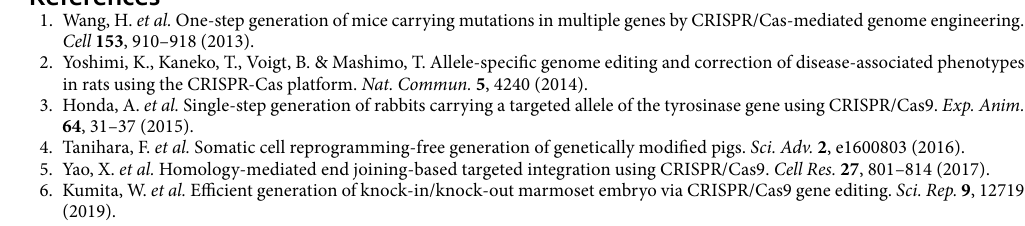
Supplementary Table 2. For genotyping of mouse Rosa26 and rat Thy1 loci, nested PCR was performed using the external primers as follows: 5 ′ -GCT CTC GGG GCC CAG AAA AC-3 ′ and 5 ′ -GAC TTC TAA GAT CAG GAA AG-3 ′ (mouse Rosa26 ); 5 ′ -ATG ACA TTC GCT GTC ATA AC-3 ′ and 5 ′ -CAG CAG AGA GAA CAC ATA TC-3 ′ (rat Thy1 ). Immunoblotting and